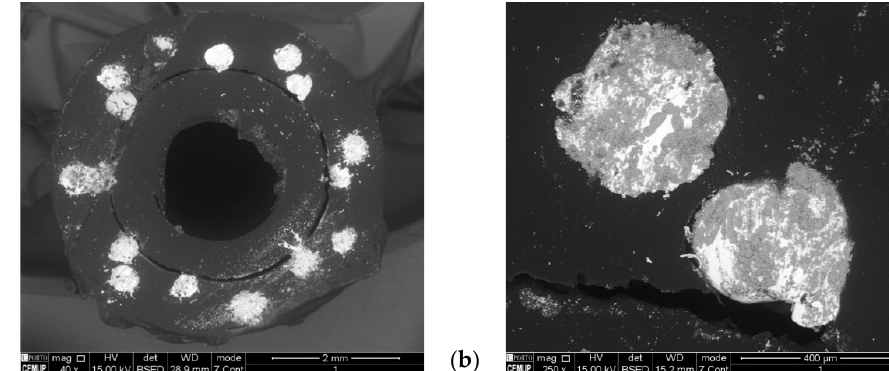
Figure 10. Microscopic images for the braided spiral with diamond disk cut: magnification of 40× ( a ) and 250× ( b ).